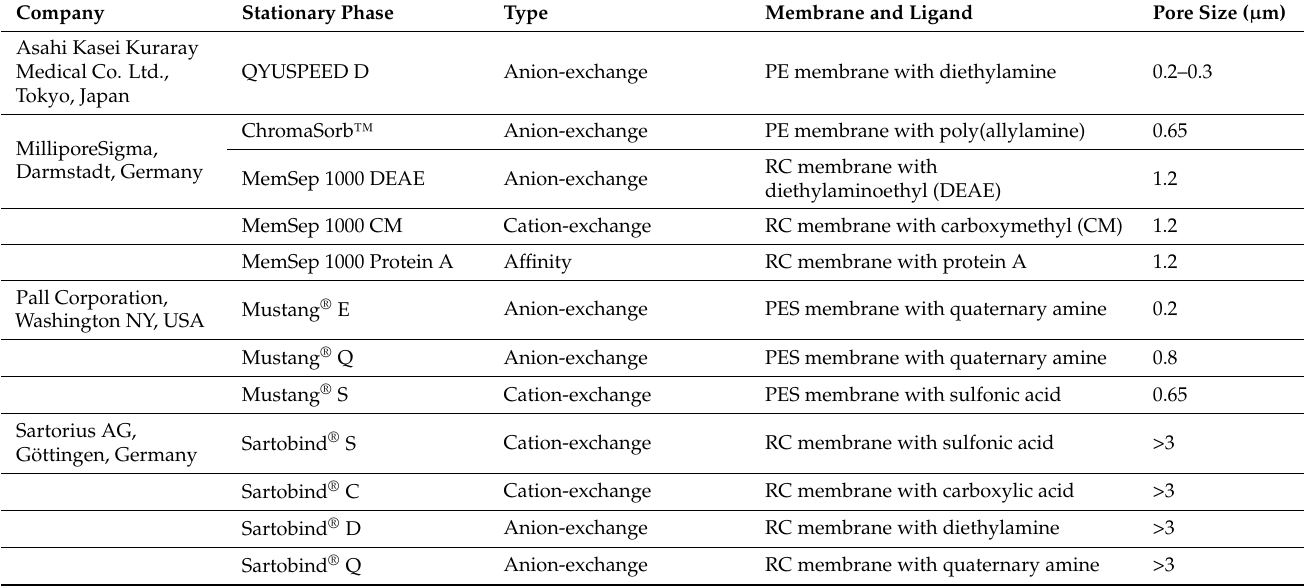
Table 2. Stationary phase (functionalized membrane) of commercialized MC system along with their characteristics (Self-developed, concept was adopted from Orr et al., 2013 [46], Liu et al., 2017